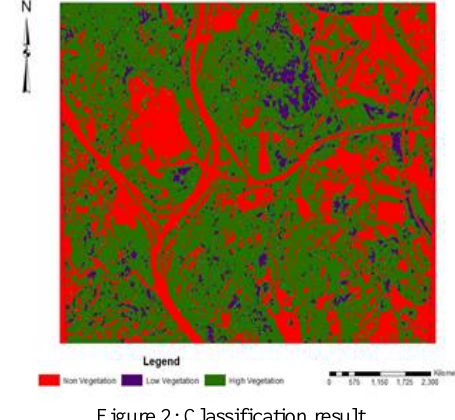
Figure 2: Classification result